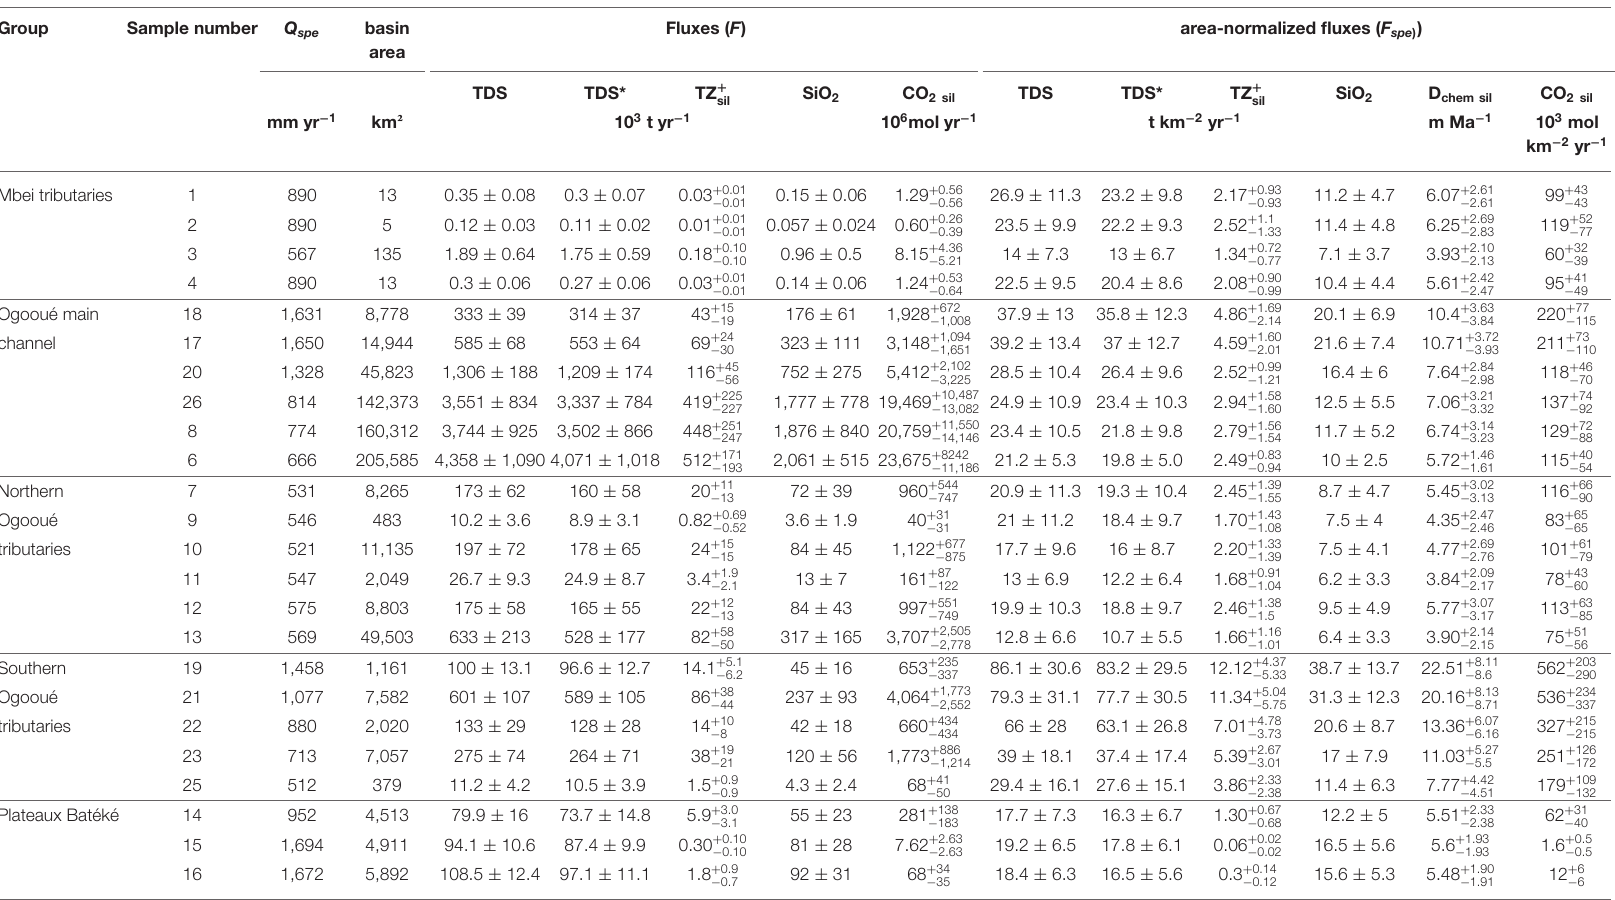
TABLE 4 | River fluxes and area-normalized fluxes of TDS (Total dissolved solids), TDS*(Total dissolved solids corrected from atmospheric inputs), TZ + sil (cations derived from silicate weathering), SiO 2 , and CO 2 sil ( CO 2 consumption associated to silicate weathering) in the Ogooué and Mbei Basin, and for the main domains of the Ogooué Basin.